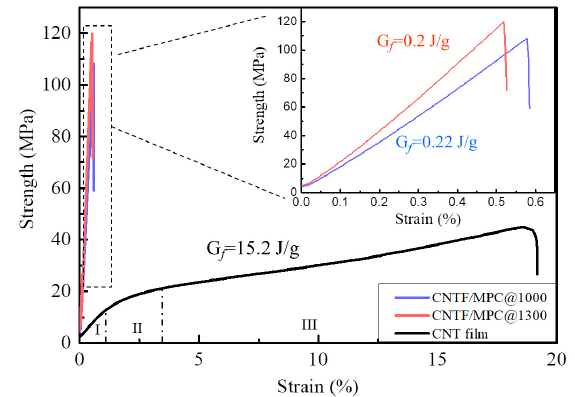
Figure 2. Typical stress–strain curves of CNT film and CNTF/MPC